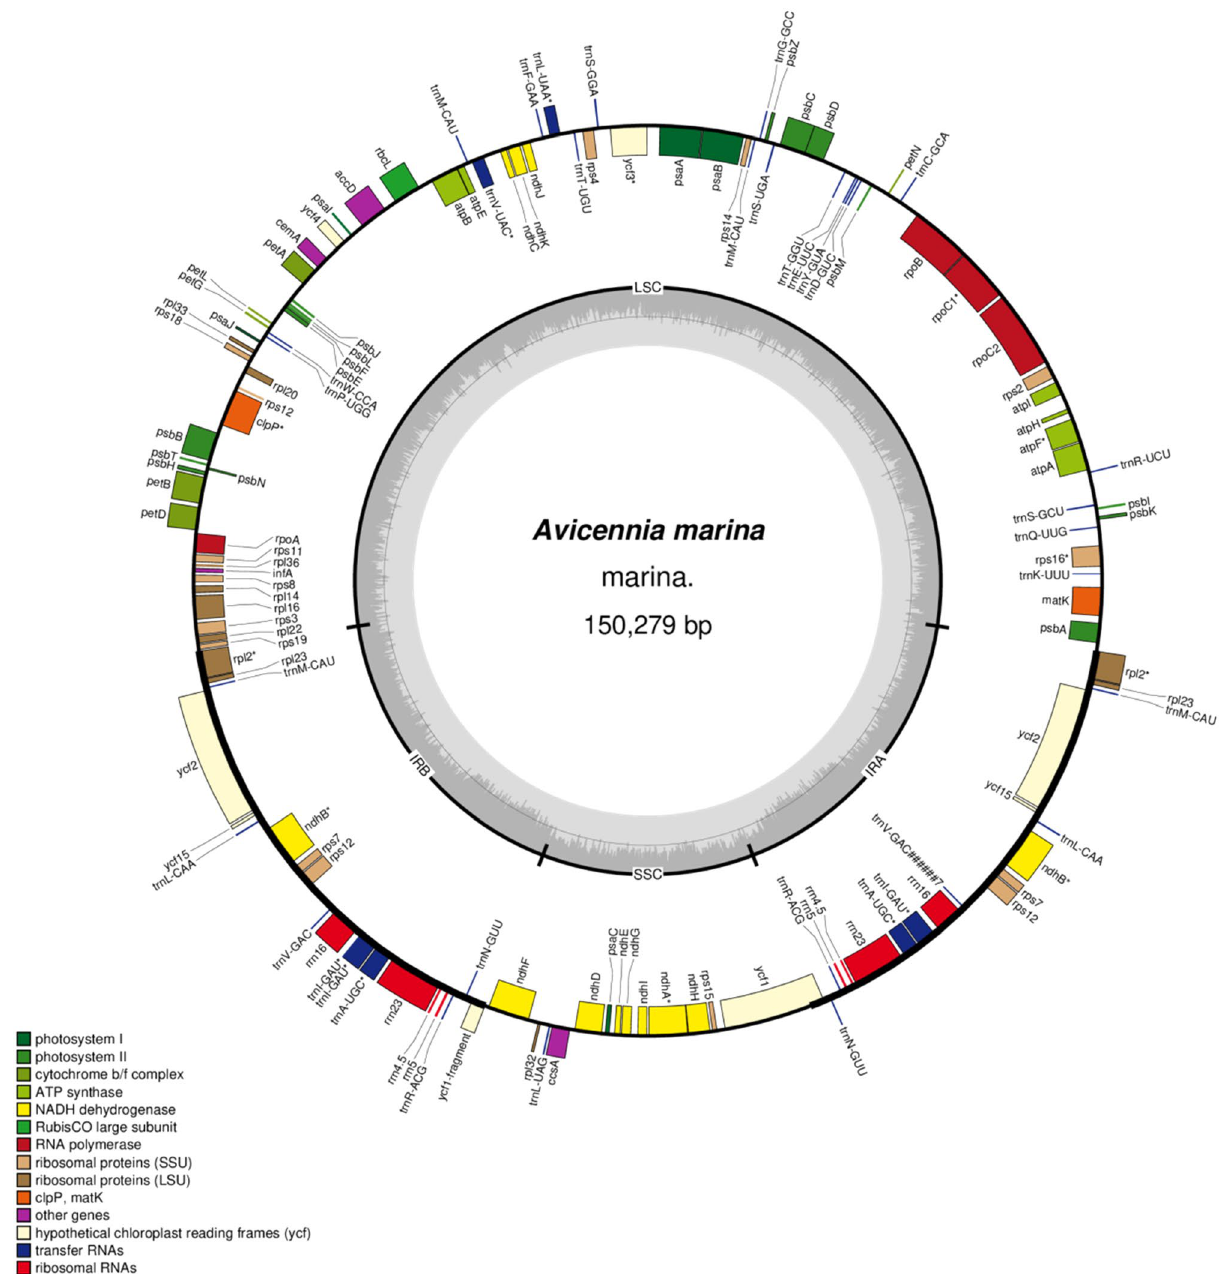
Figure 1. Gene map of the Avicennia marina chloroplast genome. Genes drawn inside the circle are transcribed clockwise, and those outside the circle are transcribed counterclockwise. The stars indicate the intron-containing genes. Genes belonging to different functional groups are colour-coded. The darker grey in the inner circle corresponds to GC content, and the lighter grey corresponds to AT region . The gene divergence was found more prominent in LSC and SSC region as compared to the IR region. In pairwise sequence divergence analysis, A. marina exhibited highest divergence (0.084) with J. flava and showed lowest divergence with A. knappiae (0.059) (Supplementary Data 1). The most divergent genes were rpl22 (J. leptostachya (0.149), rps15 in E. attenuates (0.135), ndhF A. paniculate (0.139), E. lofouensis (0.212), and matK J. leptostachya (0.139) (Fig. 2). Similarly, lowest pairwise divergence was found in genes such as, ndhB (0.003) in E. longzhouensis , psbL (0.009) in E. lofouensis , petN (0.011) in E. longipes. psaJ (0.015) in E. attenuates . Simple sequence repeat (SSR) analysis of A. marina cp genome. We determined SSRs in the cp genome of A. marina as well as in the cp genomes of the other ten related species (Fig. 3A). A total of 126 SSRs were found in the chloroplast genome of A. marina. Among the predominant SSRs nucleotides such as mononucleotide, dinucleotide, trinucleotide, etc., the mononucleotide SSR was found the most abundant not